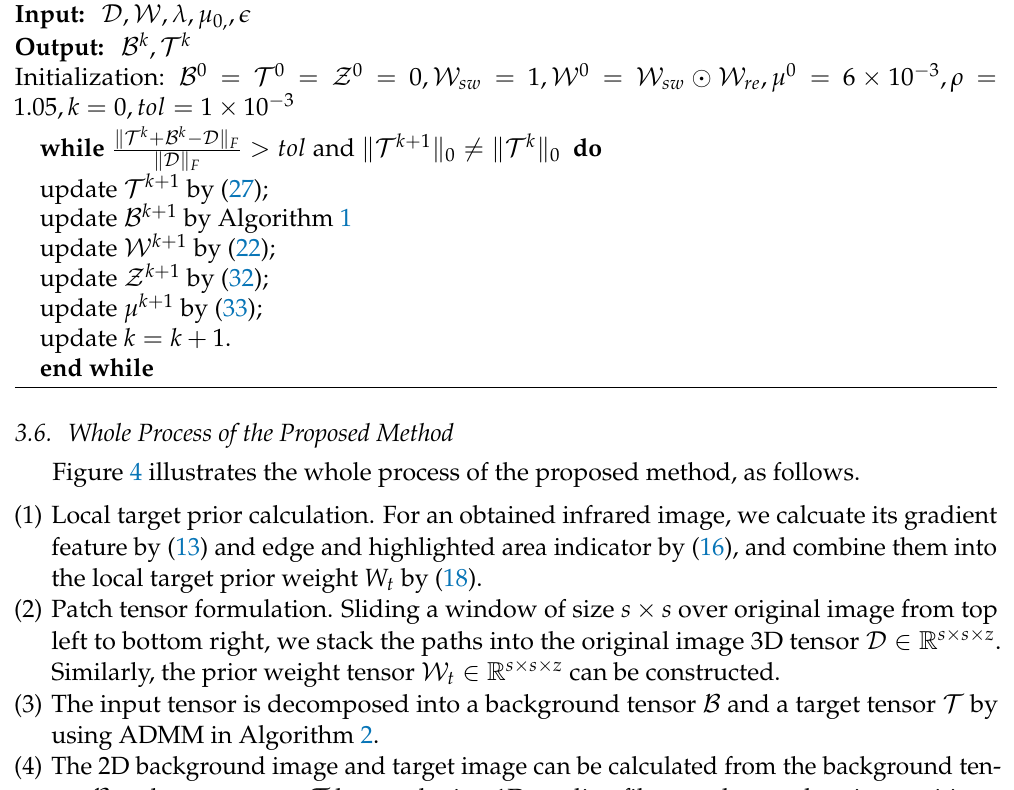
Algorithm 2 The proposed model solved by ADMM